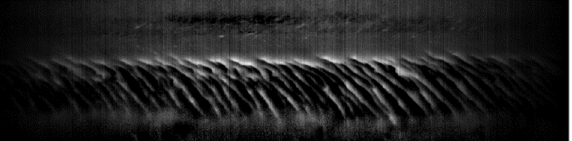
Figure 7. ( a ) Overlapping of two consecutive phase images with marked region of interest for phase correlation; ( b ) shift of the second image according to the result of the phase correlation.